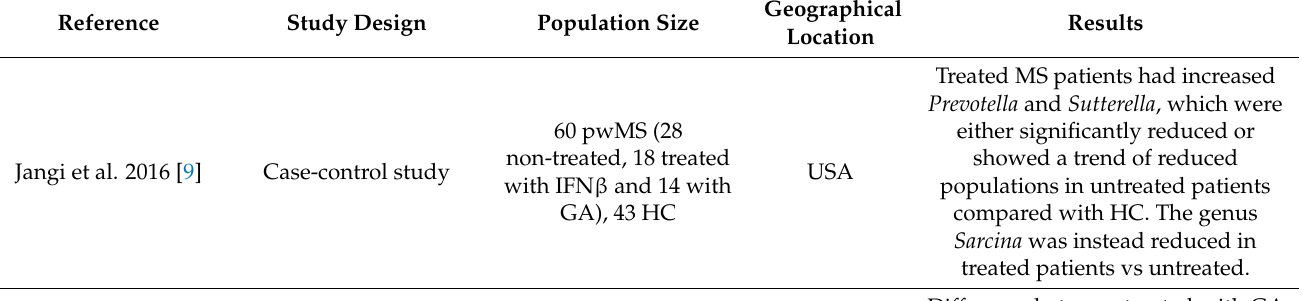
Table 6. Studies on the impact of DMTs for MS on the gut